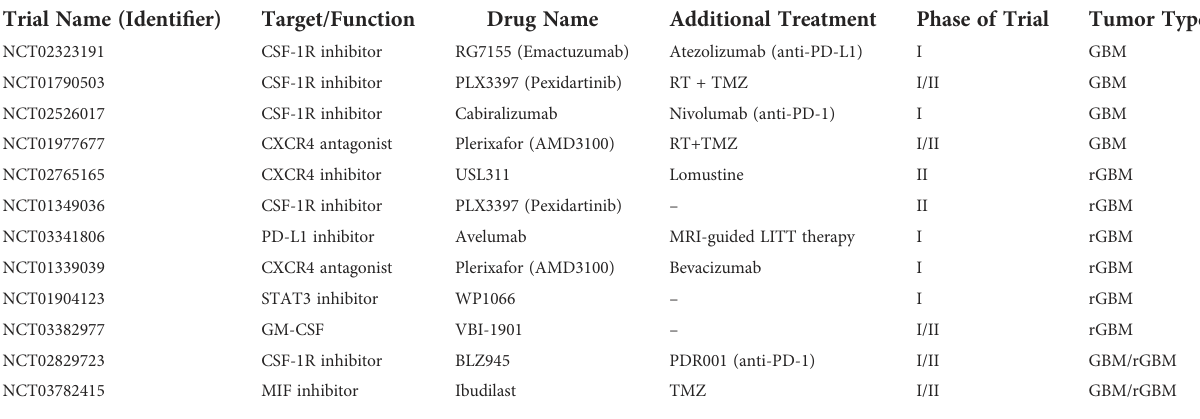
TABLE 1 Clinical trials targeting TAMs in